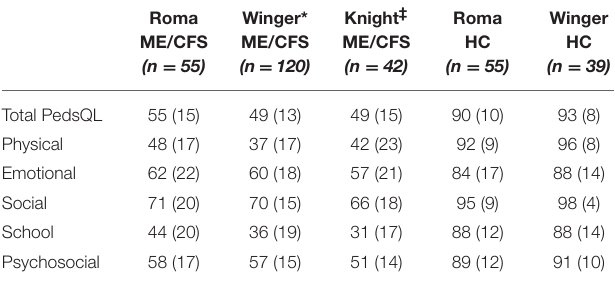
TABLE 4 | Comparison of PedsQL total and subscale scores with other pediatric ME/CFS